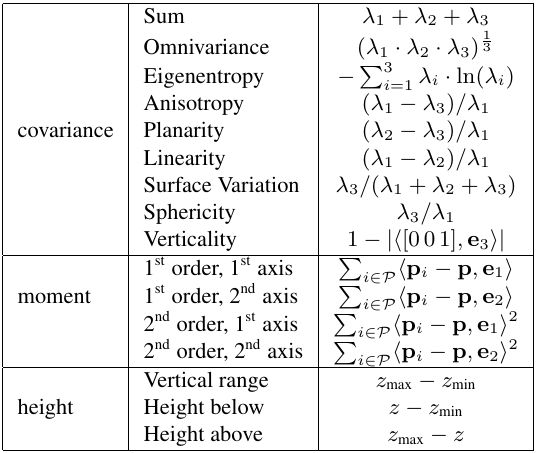
Table 1. Our basic feature set consists of geometric features based on eigenvalues of the local structure tensor, moments around the corresponding eigenvectors, as well as features computed in ver- tical columns around the point.